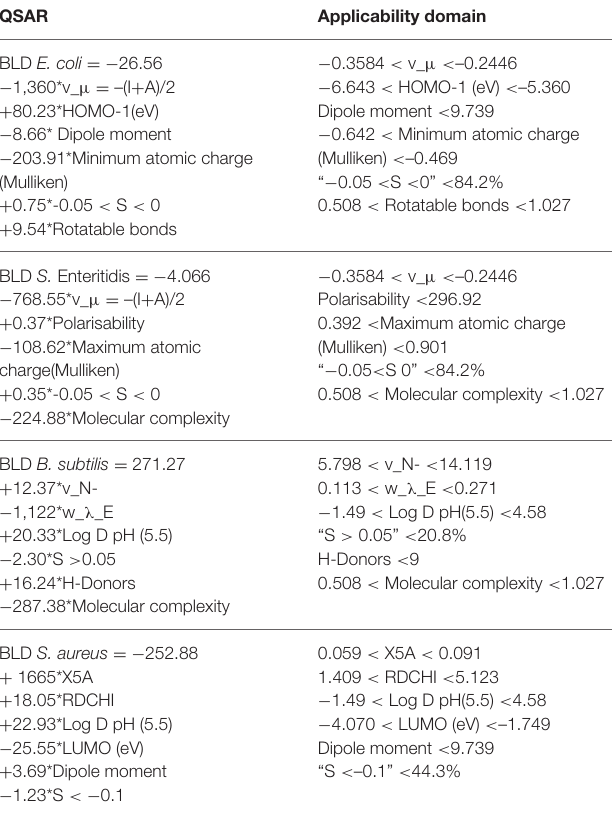
TABLE 3 | QSAR models and their applicability domain for the prediction of BLD depending on the bacterial strain considered: E. coli ATCC25922, S. Enteritidis E0220, B. subtilis ATCC6633, and S. aureus CNRZ3.